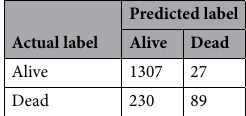
Table 7. Confusion matrix obtained using RF classifier.